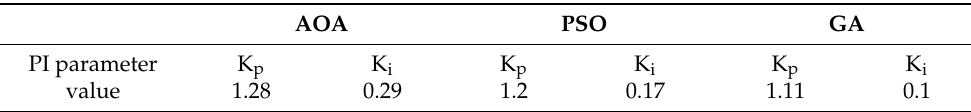
Table 8. Optimized PI parameters for (L-L)